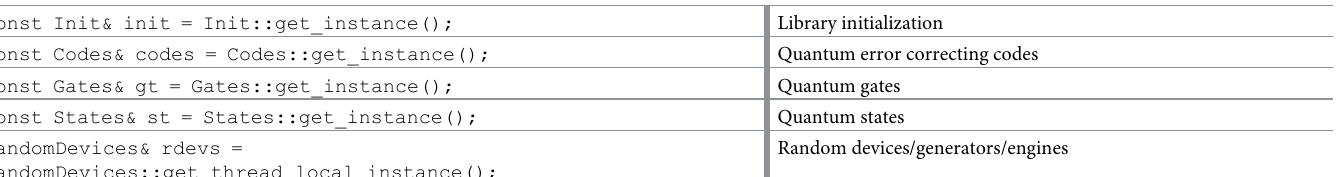
Table 3. Global singleton classes and